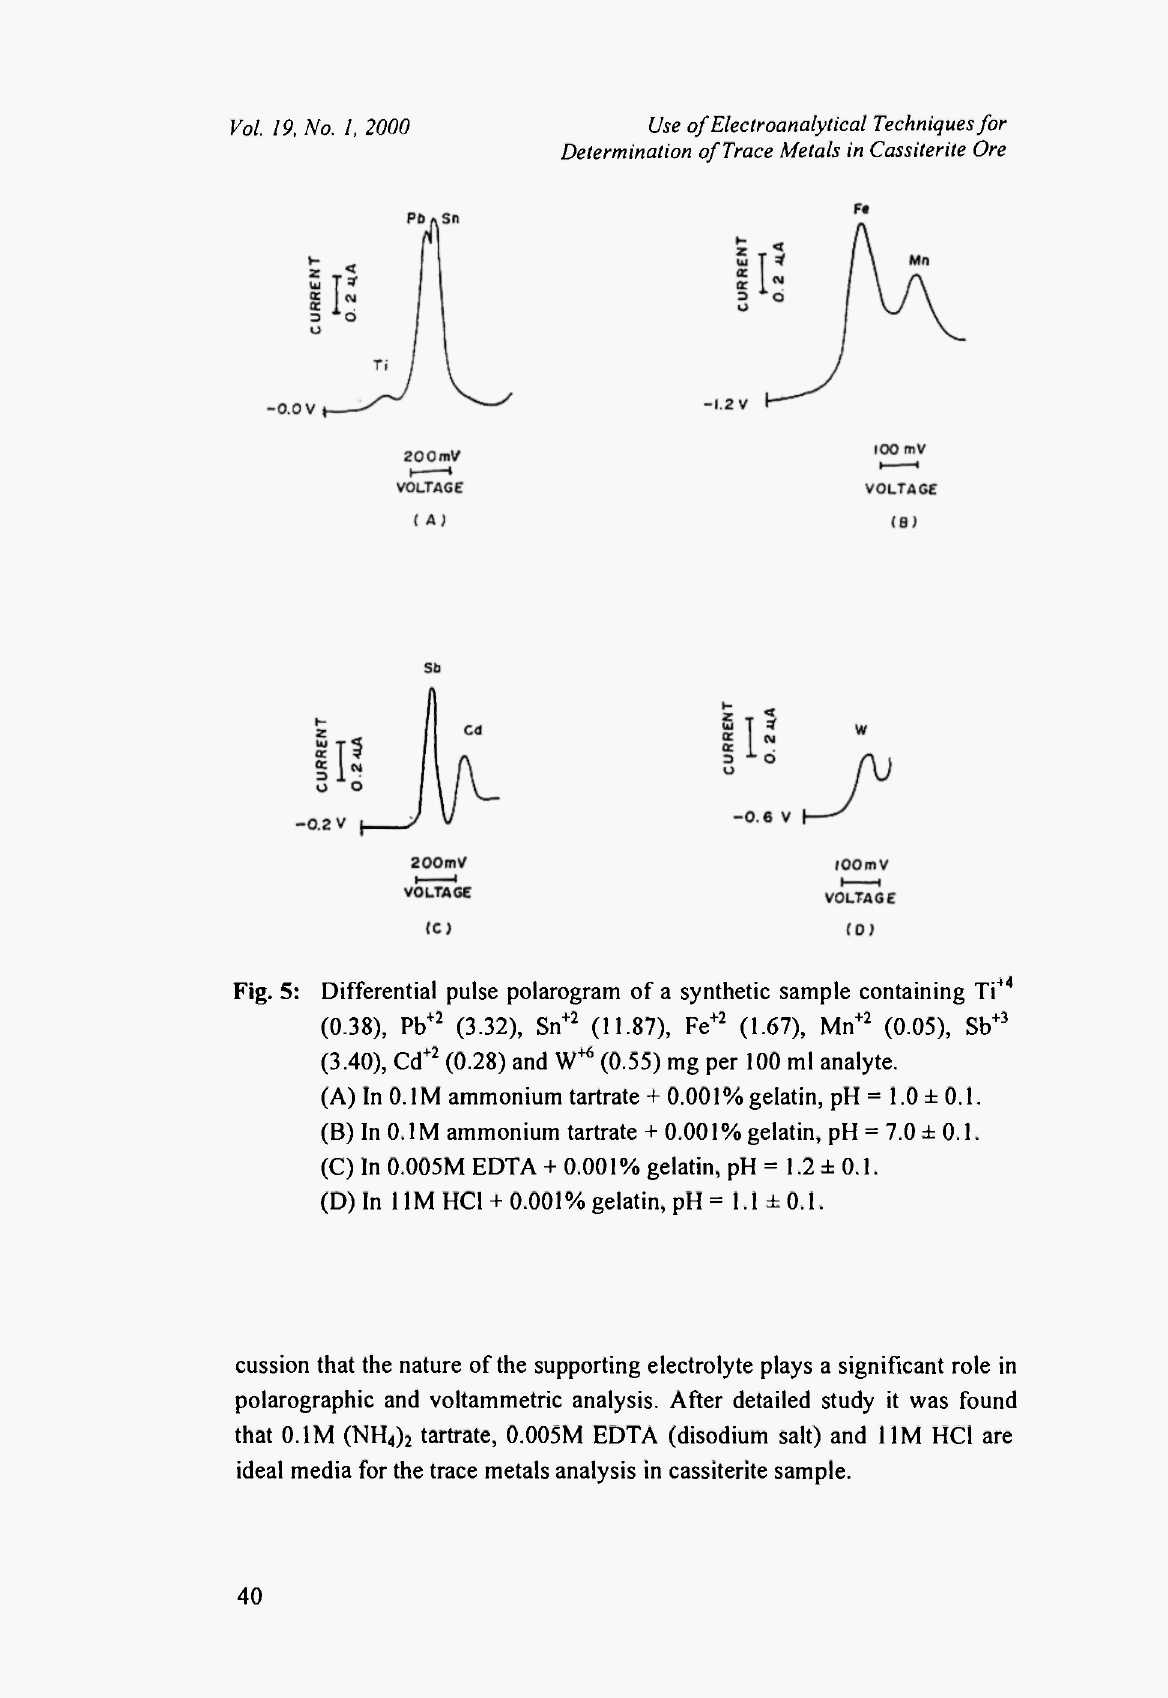
cussion that the nature of the supporting electrolyte plays a significant role in Polarographie and voltammetric analysis. After detailed study it was found that 0.1M (NH 4 ) 2 tartrate, 0.005M EDTA (disodium salt) and UM HCl are ideal media for the trace metals analysis in cassiterite